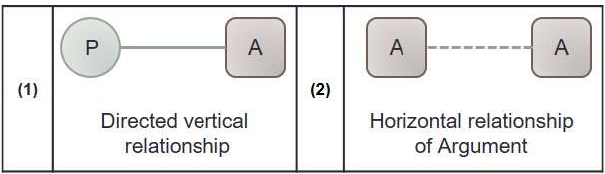
Figure 2. Relationship notation for visual modeling.